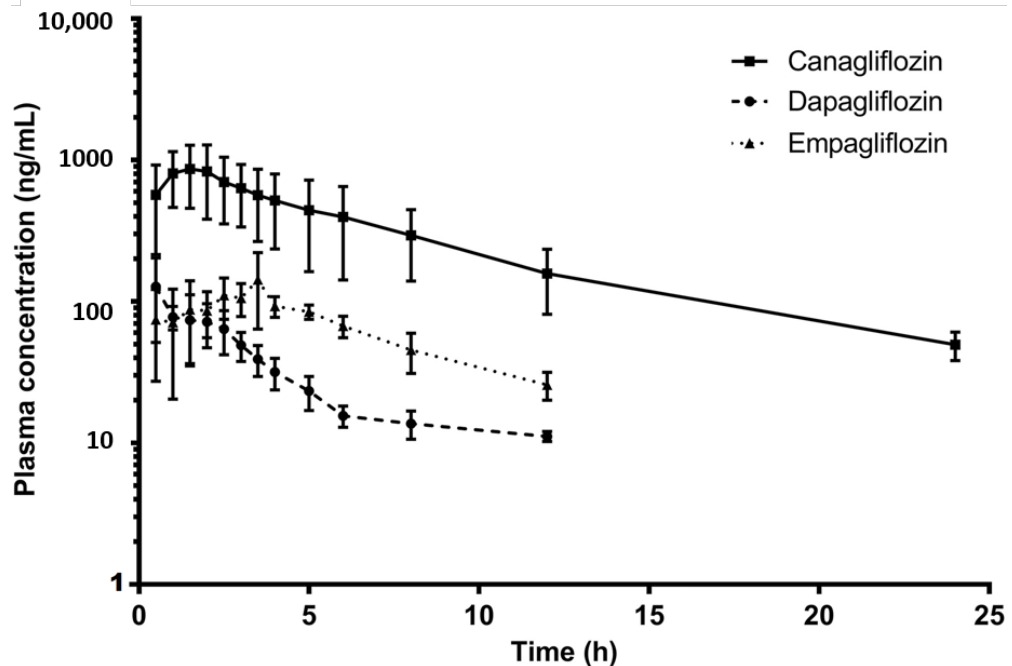
Figure 14. Gliflozin's pharmacokinetic profile in association with metformin (1000 mg). The gliflozin doses were 100, 10, and 10 mg for canagliflozin, dapagliflozin, and empagliflozin, respectively. Data are presented as a mean ± standard deviation and n = 6 for each group [150].